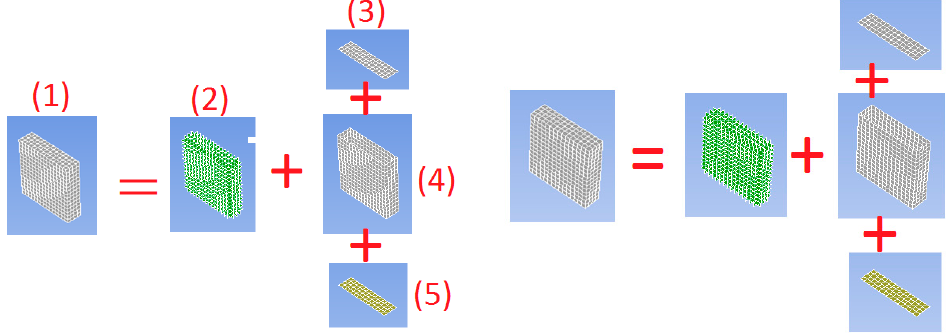
Figure 2. Different components of ( a ) positive current tab ( b ) negative current tabs.